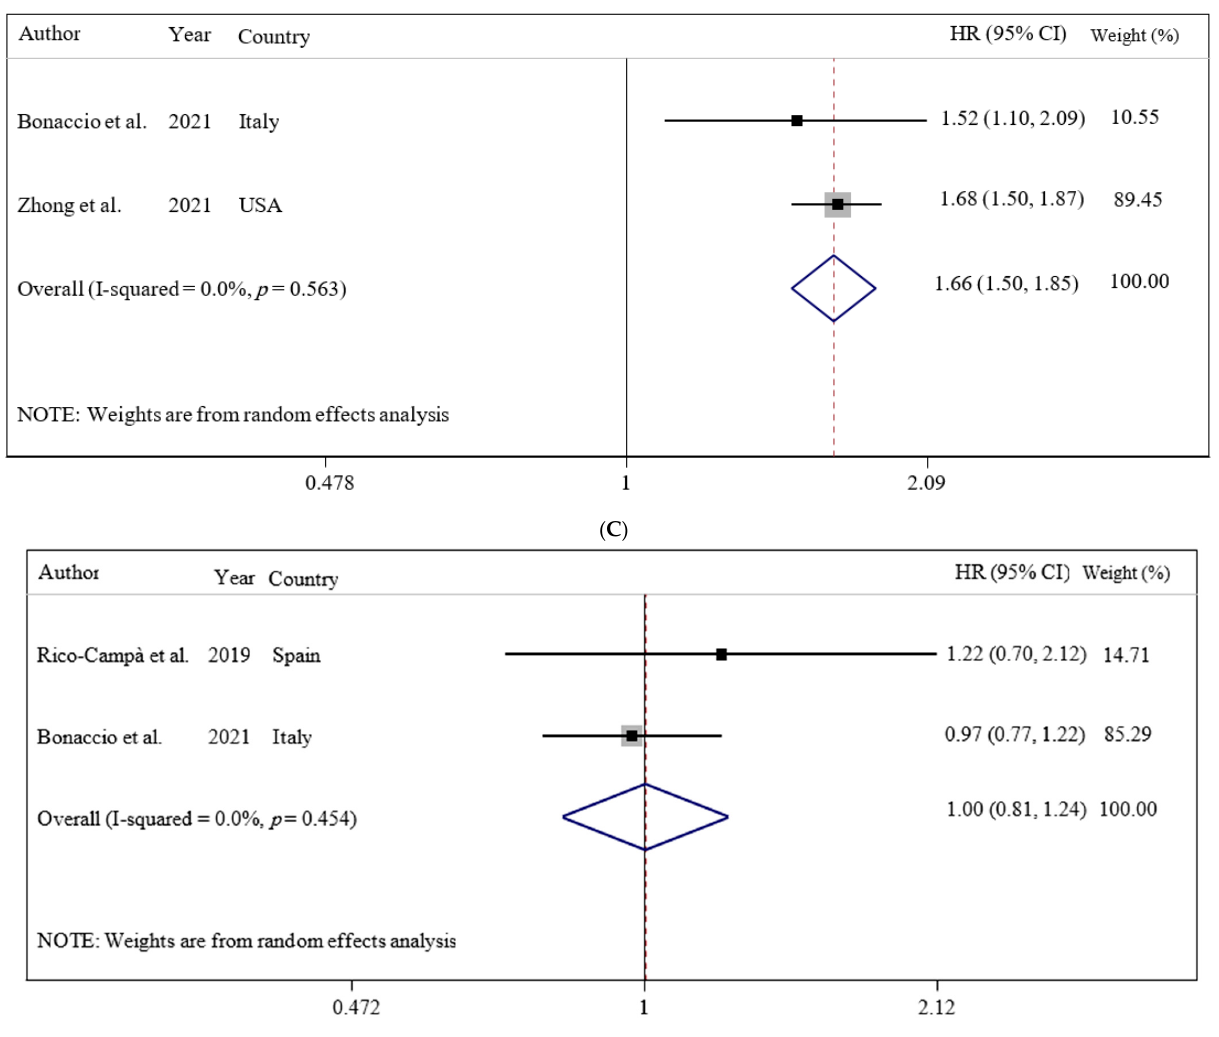
Figure 2. Forest plots demonstrating OR and 95% CI of pooled results from the random effects models to evaluate the relationship between ultra-processed food consumption and risk of mortality: ( A ) all-cause, ( B ) CVD-cause, ( C ) heart-cause, and ( D ) cancer-cause. The study-specific HR and 95 % CI are represented by black squares and horizontal lines, respectively; the area of the grey square is proportional to the specific-study weight to the overall meta-analysis. The center of the open diamond and the vertical dashed line represent the pooled HR, and its width represents the pooled 95 % CI.